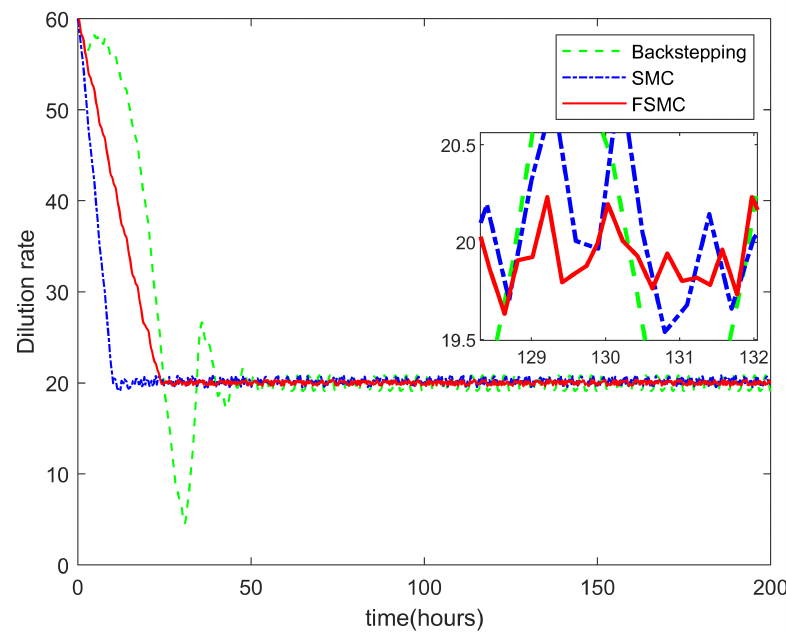
Figure 5. Substrate